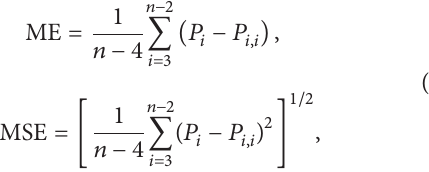
Figure 1: Textural composition of 353 soils samples used in the evaluation of interpolation